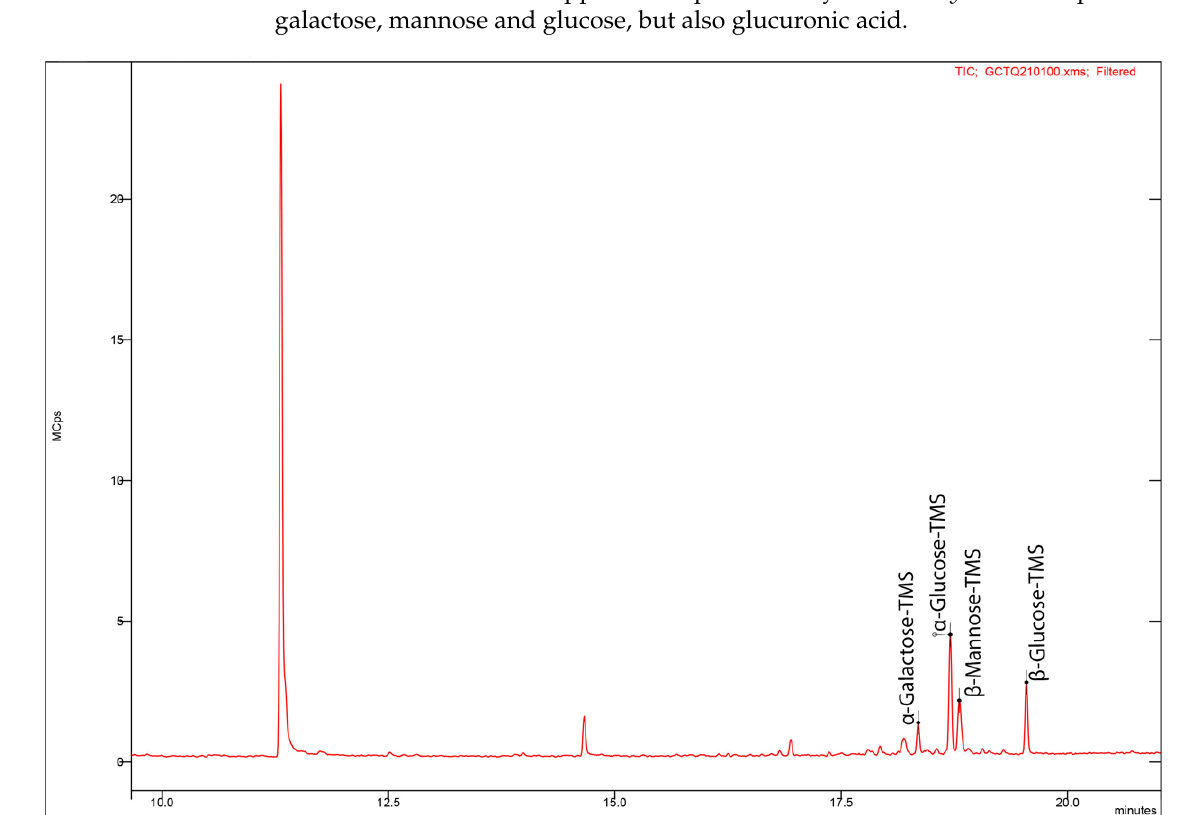
Figure 3. GC–MS gas chromatography analysis for characterisation of EPS t .